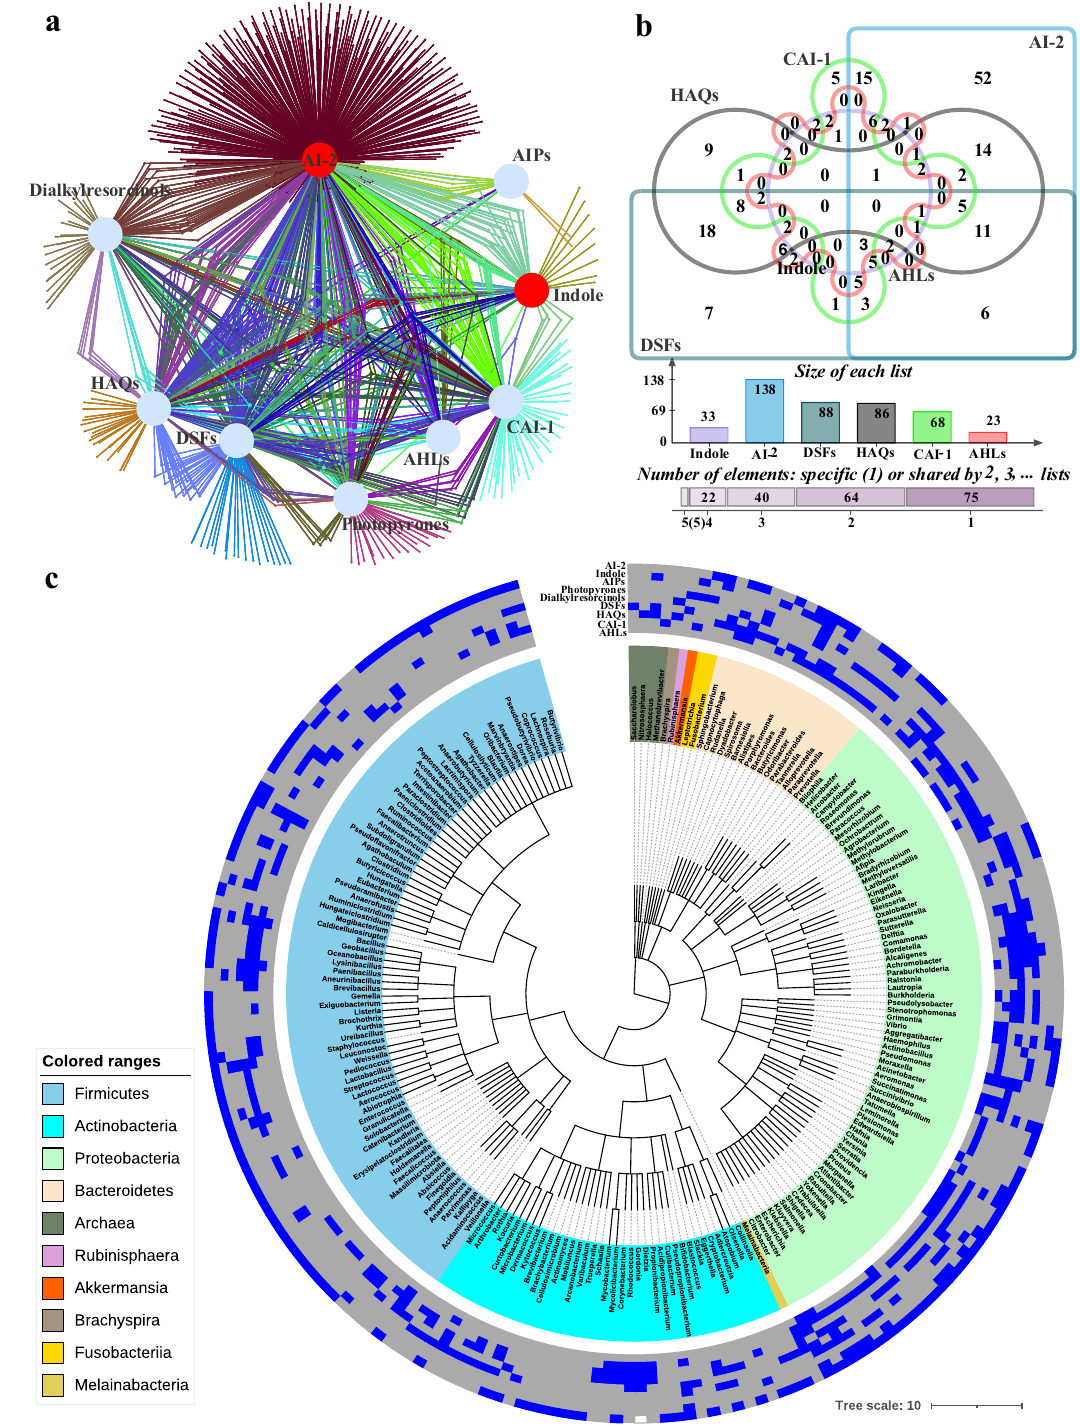
Fig. 5 QSCN for human gut microbiota based on diverse QS languages. a QSCN for 818 human gut microbes based on nine languages (AHLs, DSFs, HAQs, CAI-1, AIPs, Dialkylresorcinols, Photopyrones, indole, and AI-2). Generally recognized intraspecies and interspecies languages are marked in blue and red, respectively. Note that the network diagram was generated using EVenn 64 . b Microbial genus distribution for six typical QS languages, i.e., AHLs, CAI-1, HAQs, DSFs, Indole, and AI-2. c Hierarchical clustering of nine QS languages found in 210 human gut microbial genus. The constructions are classi fi ed into ten genus-level clusters based on their phyla and taxonomy. Microbial genus from Firmicutes is colored in blue; Actinobacteria, cyan; Proteobacteria, green; Bacteroidetes, yellowish. Heatmap on the outermost layer indicates QS languages distribution in each cluster, existence is colored in blue; no existence, gray. Source data are provided as a Source Data fi